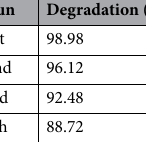
Table 5. Evaluation of various parameters for reusability test of photocatalyst for MG dye